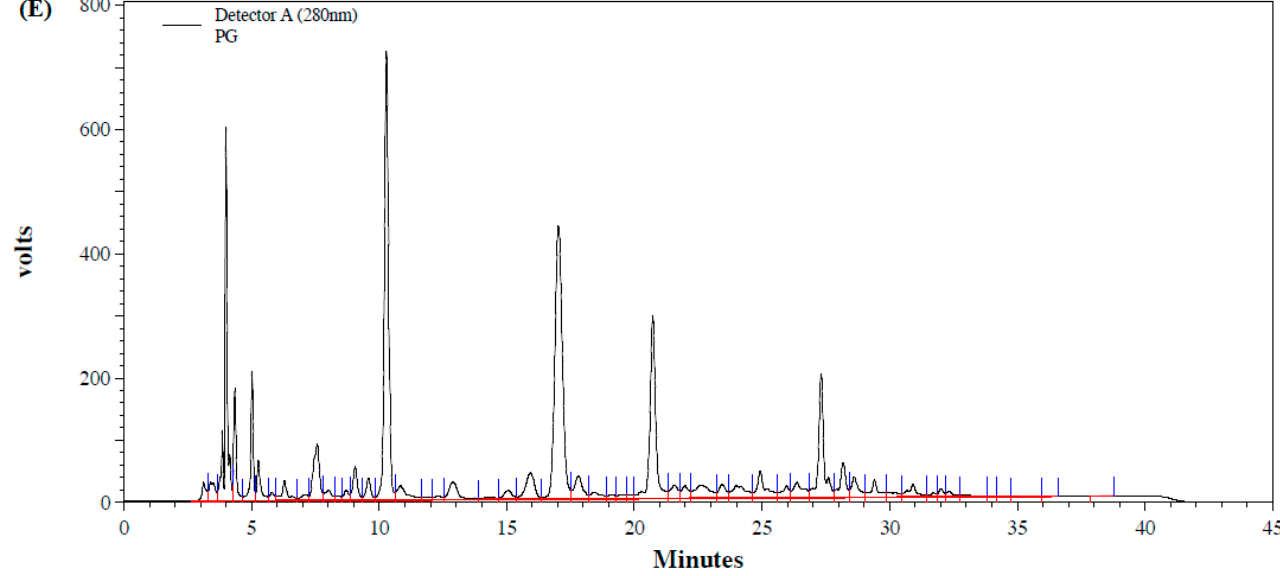
Figure 1. The high-performance liquid chromatography system to analyze the major constituents in various tea extracts. The major constituents in various tea extracts were determined by comparing their retention times to authentic standards in the high-performance liquid chromatography analysis. ( A ) standards; ( B ) TB; ( C ) TG, ( D ) PB and ( E ) PG. Abbreviations: T: Taiwan Tea Experiment Station No. 12; P: purple shoot tea; G: green tea; B: black tea.